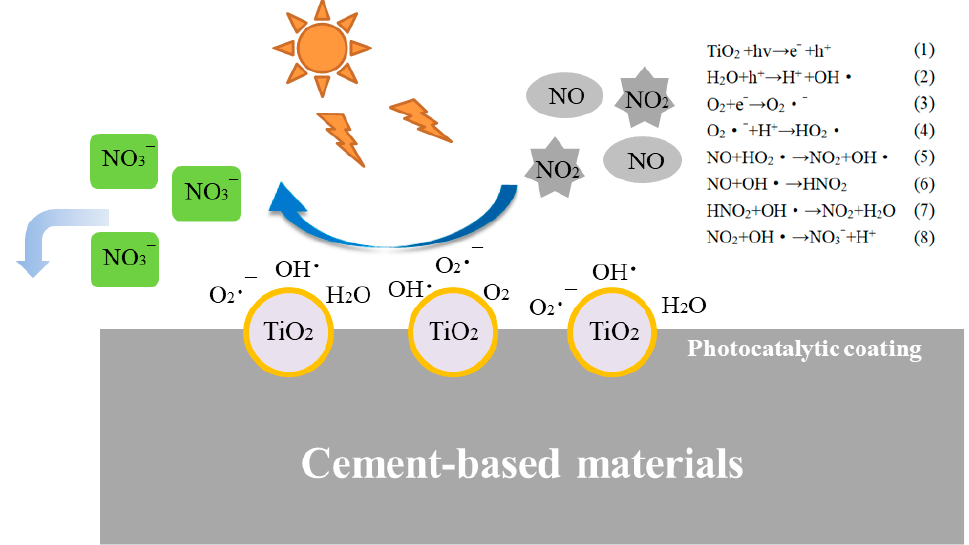
Figure 1. Reaction mechanism of photocatalytic oxidation of NO x by TiO 2 .